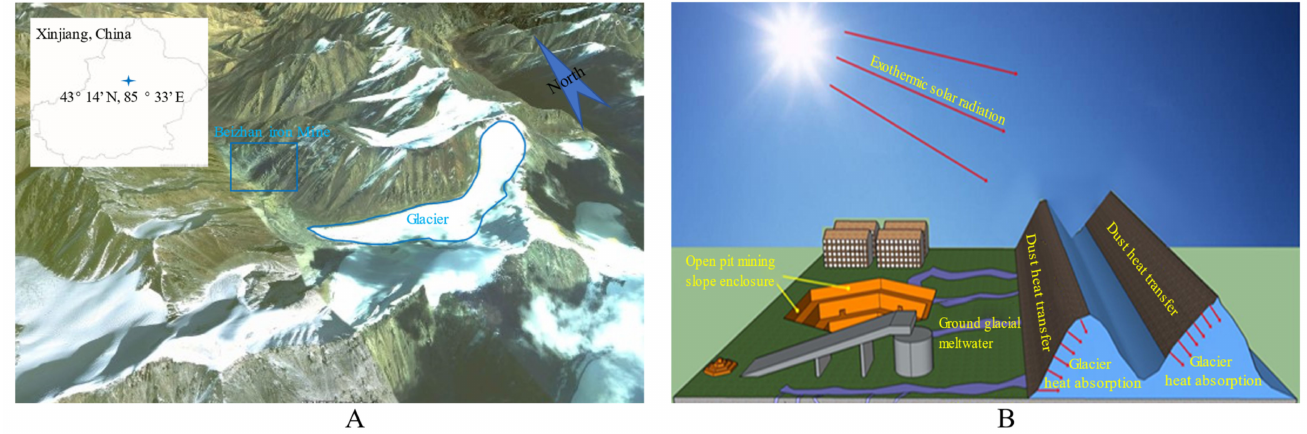
Figure 1. Location of the research area, spatial distribution of the mining area and glacier ( A ); diagram of dust accelerating glacier ablation ( B ).